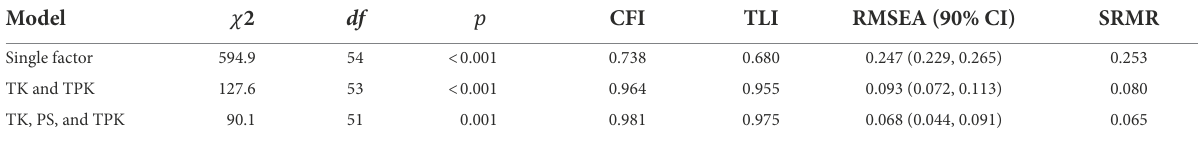
TABLE 2 Fit indices different numbers of factors in a CFA (general statements of technological and technological pedagogical knowledge, 𝑁 = 165).